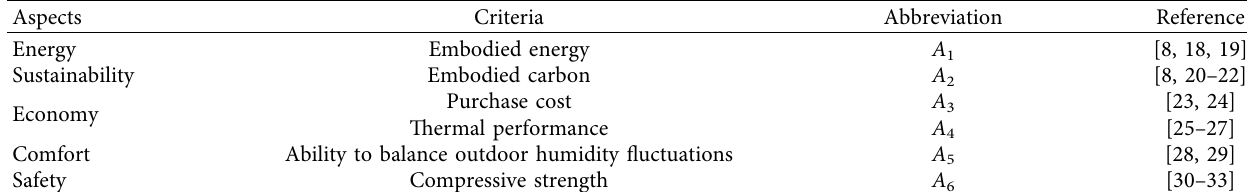
Table 1: Criteria for concrete material